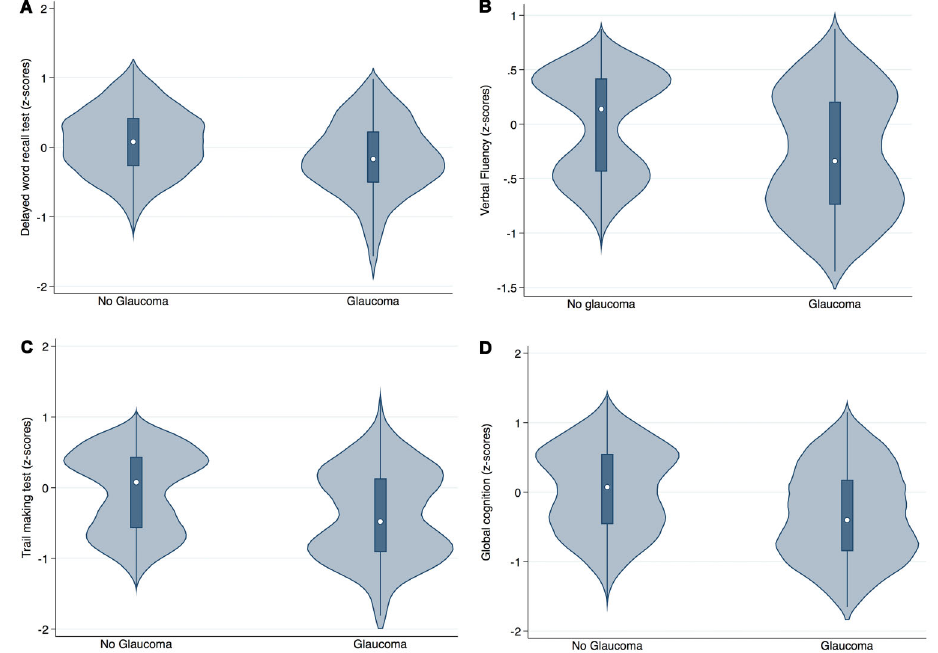
Figure 2. Cognitive performance in participants with and without glaucoma. Violin plots of the adjusted predicted values of z-scores of ( A ) delayed word recall test, ( B ) verbal fl uency task, ( C ) trail making test, and ( D ) global cognitive composite score according to glaucoma status. Signi fi cant results were found only for verbal fl uency task ( B ). Multiple linear regression models with robust covariance were employed, with adjustment for age, sex, ethnicity, education, ideal smoking status, ideal physical activity status, hypertension, diabetes, ideal cholesterol status, presence of cardiac conditions, body mass index, excessive alcohol use, presence of thyroid dysfunctions, and presence of